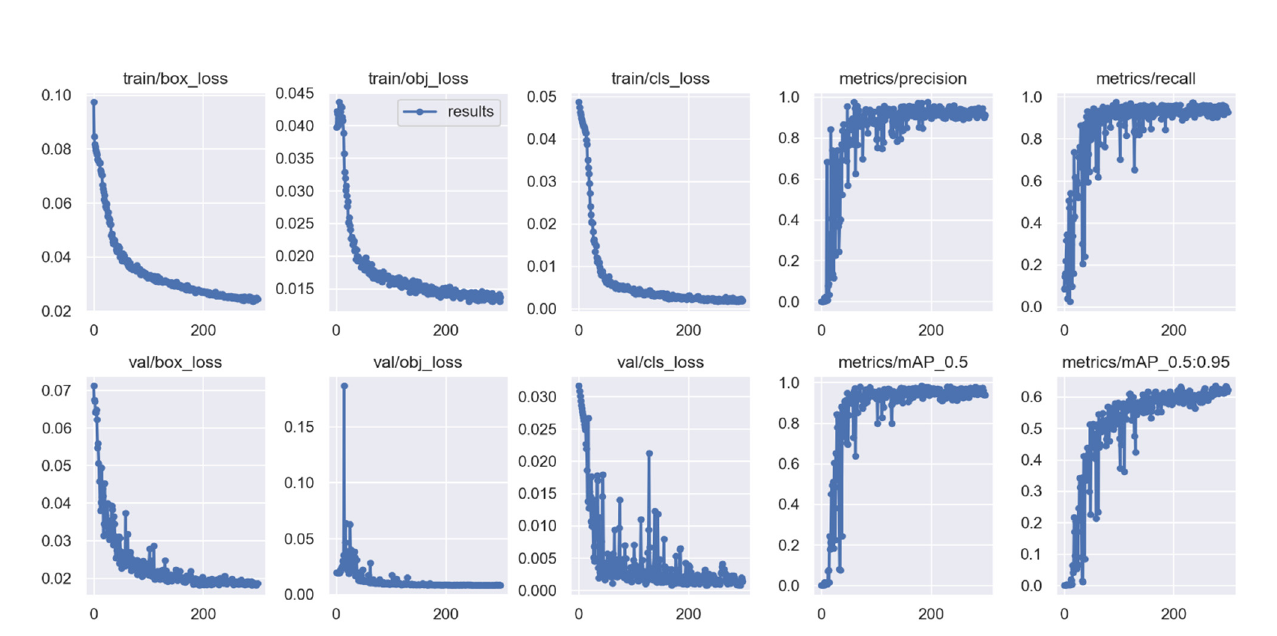
Figure 6. Shows both training and validations losses of the HCNN algorithm’s object detector and classification on 200 epochs for campus scenes dataset. The precision and recall metrics in the training and validation phase converge at the highest of 95.7% accuracy, whereas the mAP converges at 95% with a 0.5 threshold.